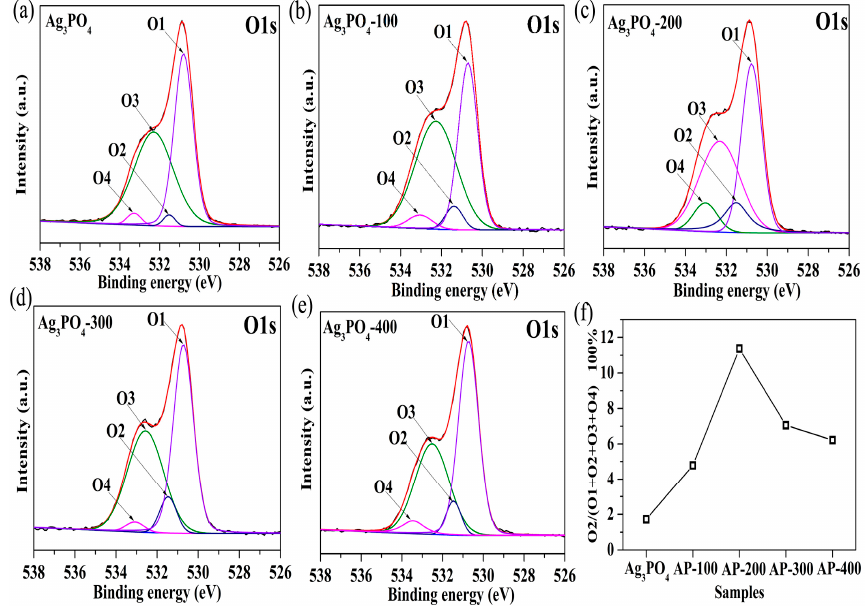
Figure 6. High-resolution XPS spectra of O1s region of pristine Ag 3 PO 4 ( a ); and Ag 3 PO 4 -T (T = 100, 200, 300 and 400) ( b – e ); and the ratios of the O2 peak area to the total area of all O1s peaks for these samples ( f ) (AP denotes Ag 3 PO 4 in ( f )).